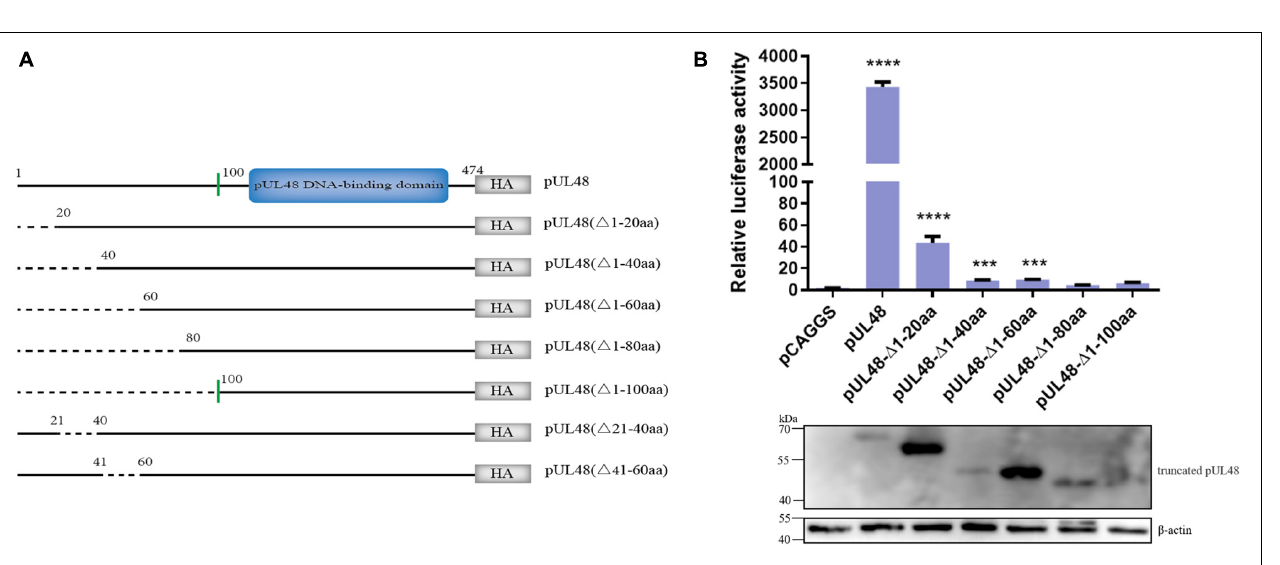
Frontiers in Microbiology |